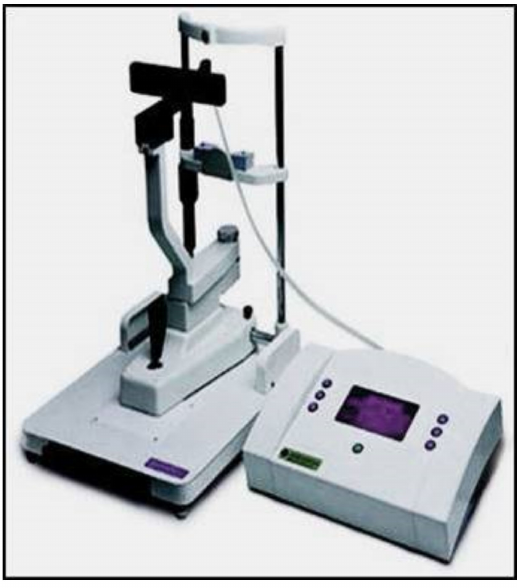
Figure 10. Langham Ocular Blood Flow